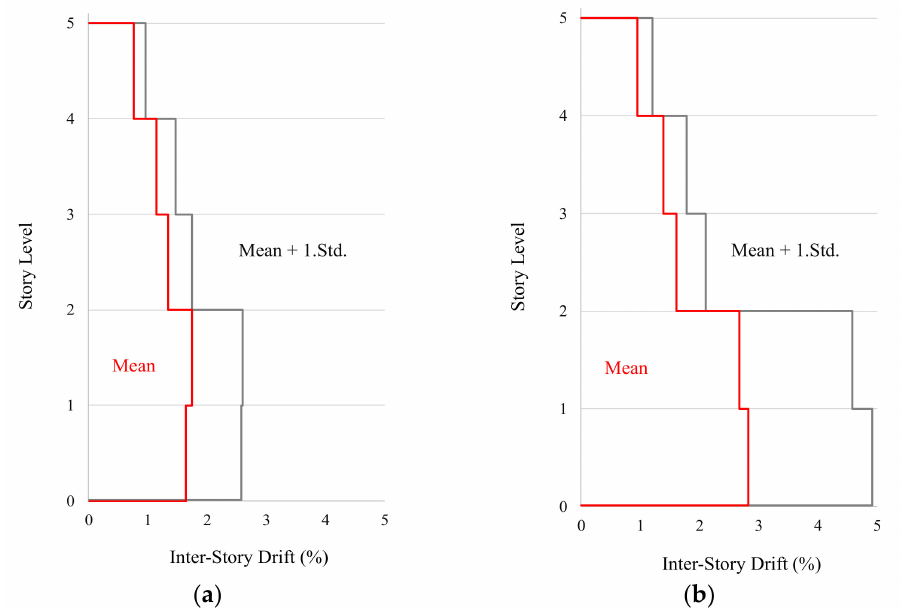
Figure 20. Inter-story drift comparison for a five-story frame using a conventional model with elastic joint ( a ) and a model with a nonlinear joint model and improved frame element formulation ( b